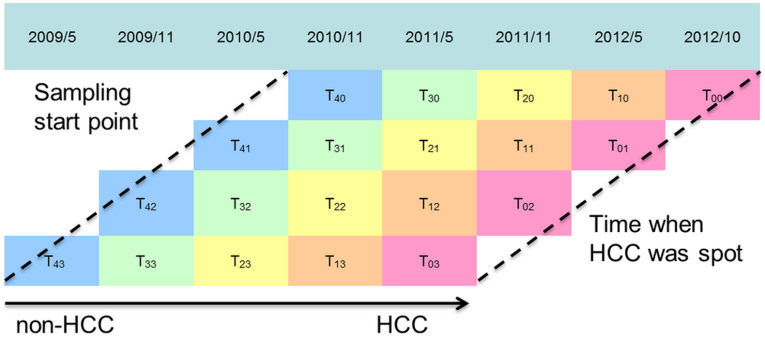
Sampling for HCC and HBsAg+ control groups from May 2009 to October 2012.T0: the stage at which patients were initially diagnosed with HCC. Serum samples were collected every 6 months prior to T0 at T1j (half a year ago), T2j (one year ago), T3j (one and a half years ago), and T4j (two years ago).